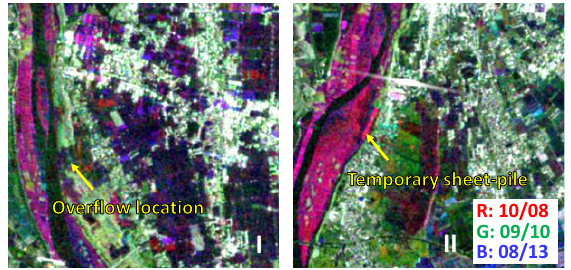
Figure 5. Multi-temporal colour composites of PALSAR-2 images for the two major damage